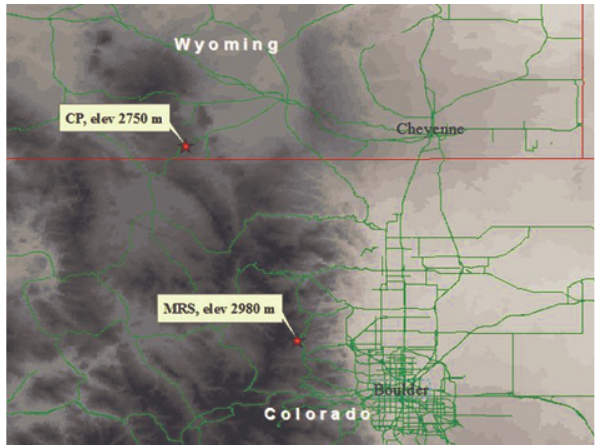
Fig. 1. Location of the Chimney Park and Mountain Research Sta- tion sampling